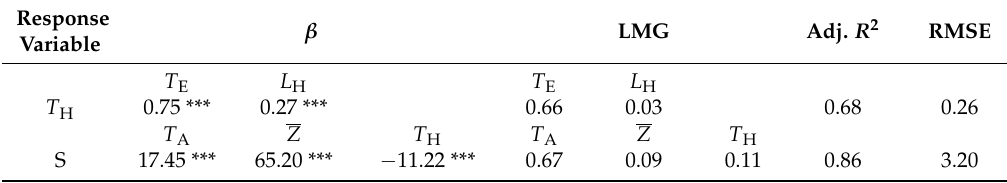
Table 3. Regression results for mean annual (January to December) temperature of the hypolimnion ( T H ) and Schmidt stability (S). Independent variables include temperatures of the epilimnion ( T E ), hypolimnion ( T H ), and air ( T A ), thickness of the hypolimnion ( L H ), and mean reservoir depth ( Z ). All values are differences between a warming scenario relative to the reference run with no change. The β is the regression parameter value and LMG is the relative contribution of each variable to the final R 2 [37,38]. Data from low water years (2002 to 2004) were excluded given that the study reservoir did not stratify